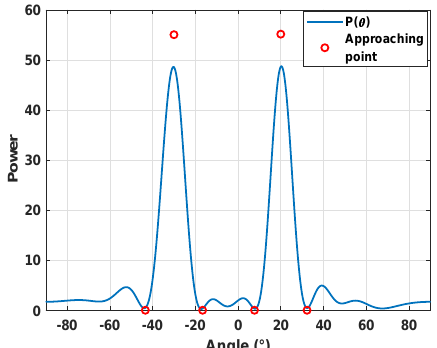
Figure 4. The transmit